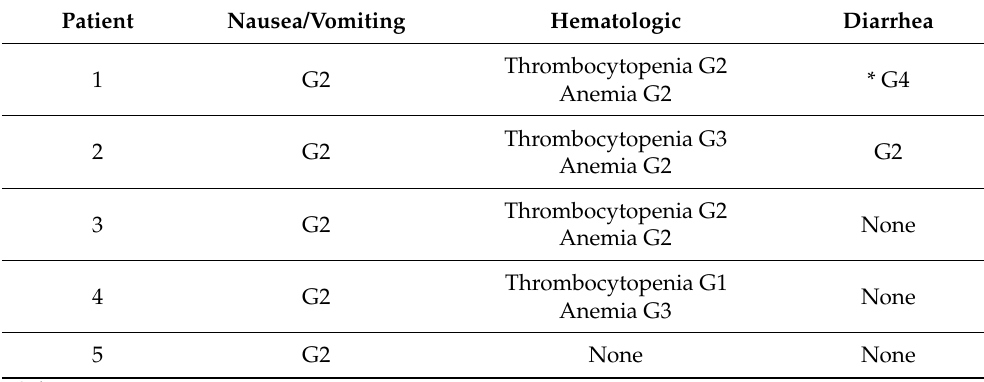
Figure 7. Overall survival on MMC treatment. Legend: Patient 3 was again censored at the time of death. The median OS was 12.3 months (95% CI = 2.2 months, upper bound not reached). Table 4. Toxicities by CTCAE v 5.0 with MMC at initial dose of 8 mg/m 2